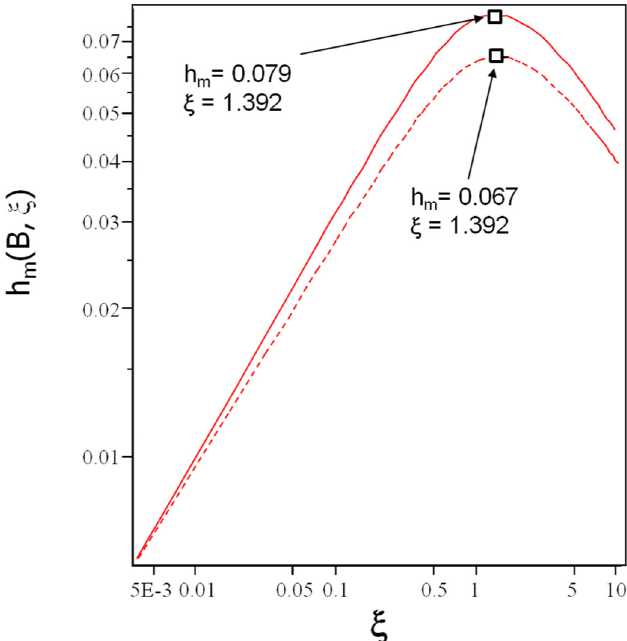
Fig. 2. (Color online) Results of the calculus of the h m ( B, ξ ) functions for 1312 − 656 nm SHG with B = 8 . 99 (straight line) and for 656 − 328 nm SHG with B = 14 . 89 (dashed